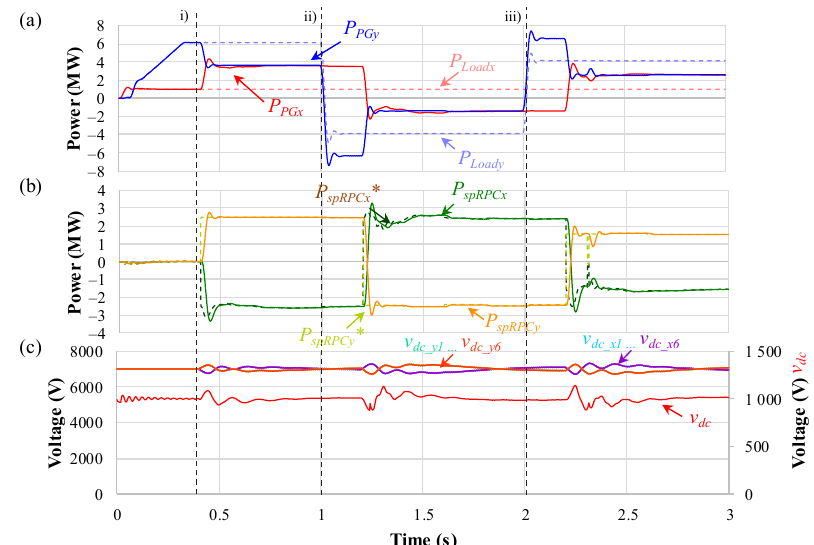
Figure 13. Evolution of active powers and voltages: ( a ) variation of the load power, P Loadx and P Loady , and the active power on each TPS, P PGx and P PGy ; ( b ) variation of sp-RPC active power, P spRPCx and P spRPCy , as well as the reference values, P spRPCx * and P spRPCy *; ( c ) variation of the common dc-link voltage, v dc , variation of the voltage of the dc-link on each submodule, v dc_x1 to v dc_x6 , and v dc_y1 to v dc_y6 .